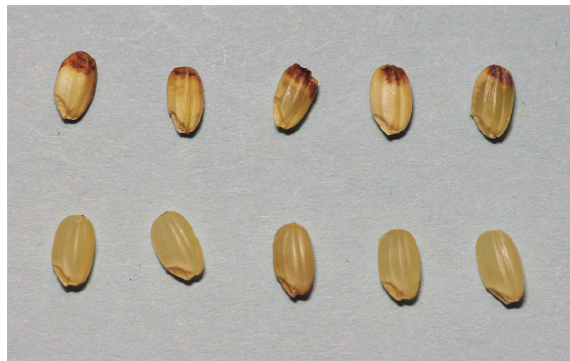
Figure 2: Damaged (pecky rice; top row) and nondamaged (bottom row) brown rice